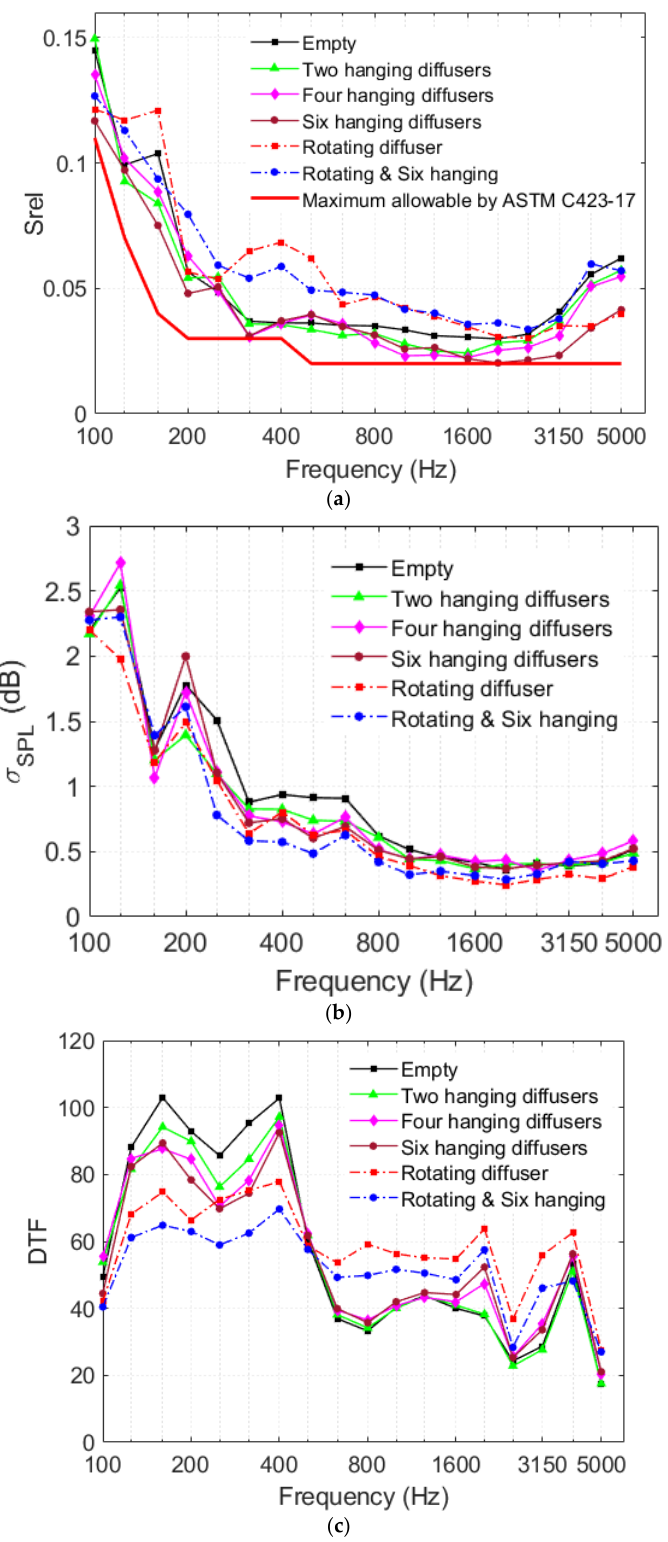
Figure 4. Diffuseness metrics of ( a ) s rel , ( b ) σ SPL and ( c ) DTF over 120 microphone positions measured in six diffuse conditions: (1) Empty, (2) Two hanging diffusers, (3) Four hanging diffusers, (4) Six hanging diffusers, (5) Rotating diffuser only, and (6) Rotating diffuser & six hanging diffusers.